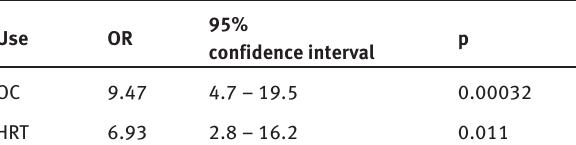
Table 8: The risk of ovarian cancer in patients taking OC and RT.